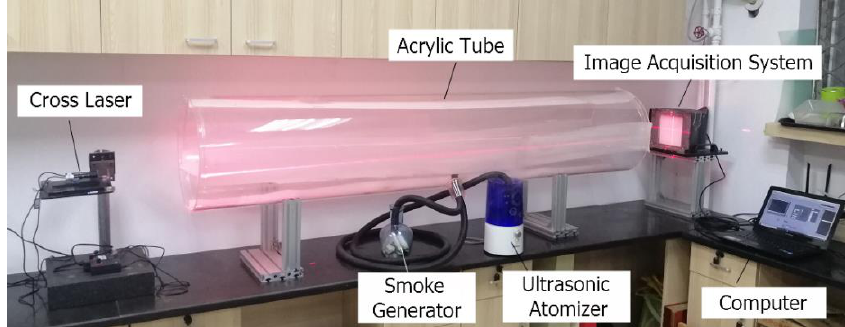
Figure 3. The simulated smoke and water mist environment.